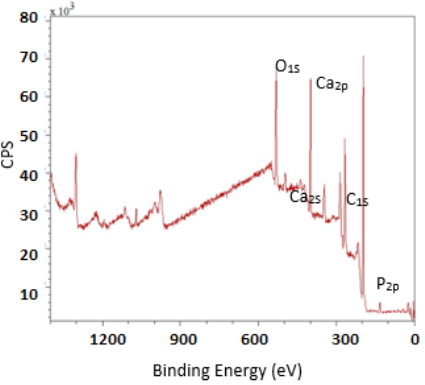
Figure 9. XPS spectra of the composite based on HAp/HPMC.